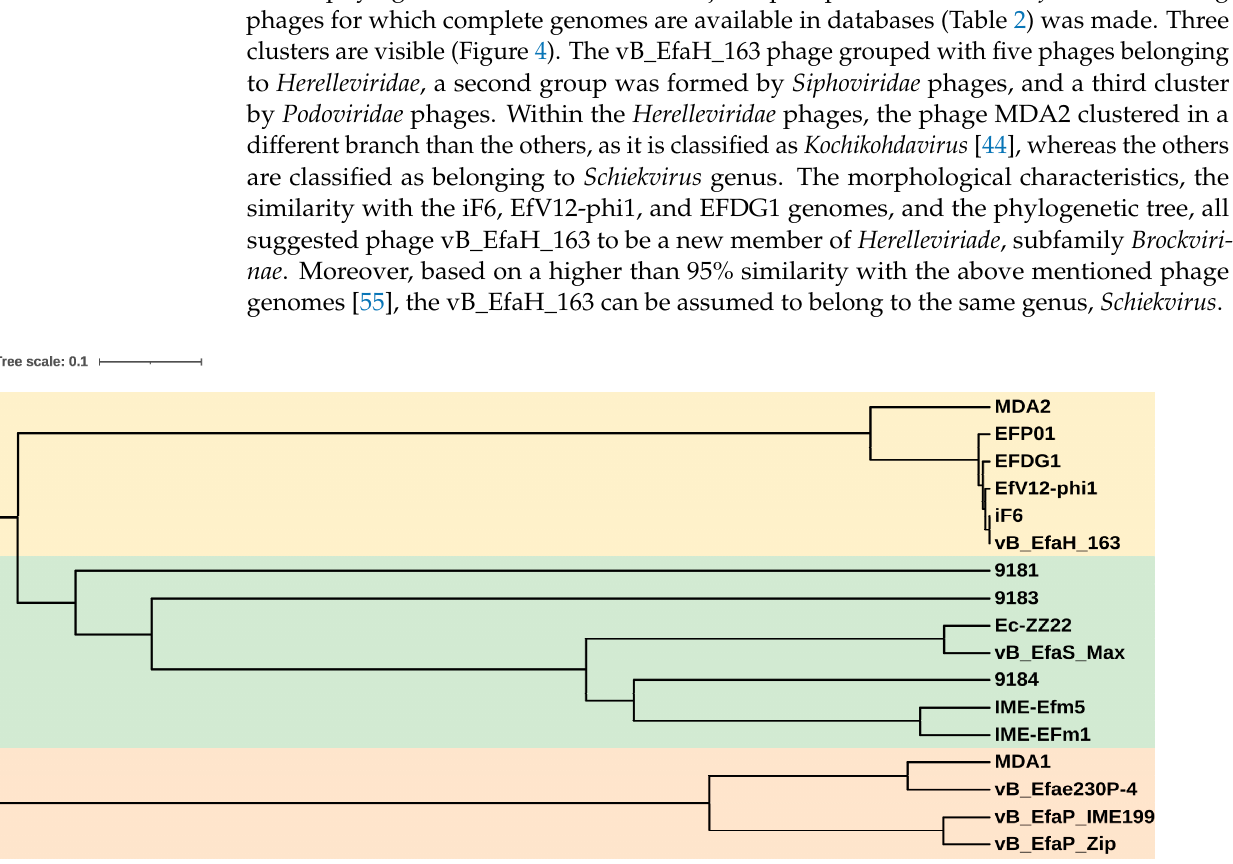
Figure 5. Technological characterisation of phage vB_EfmH_163. The effect of incubation temper- ature (22, 27, 32, 37, and 42 °C) ( A ), thermal stability (15 min-treatment at 40, 45, 50, 55, 60, 70, 80, or 90 °C) ( B ) and pH stability (15 min treatment in PBS pH 2–9) ( C ) were assessed by measuring the phage titre (Log PFU/mL). Means and standard deviations of three independent replicates are shown. *: p < 0.05; ***: p < 0.001.